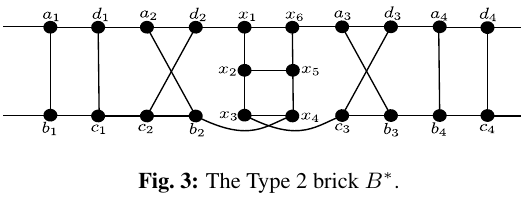
Fig. 3: The Type 2 brick B ∗ .